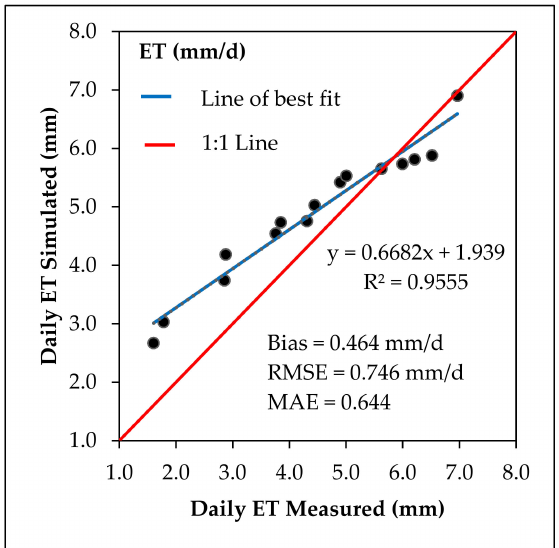
Figure 12. Comparison of the daily evapotranspiration (ET) derived from the novel TSEB with EC tower-based